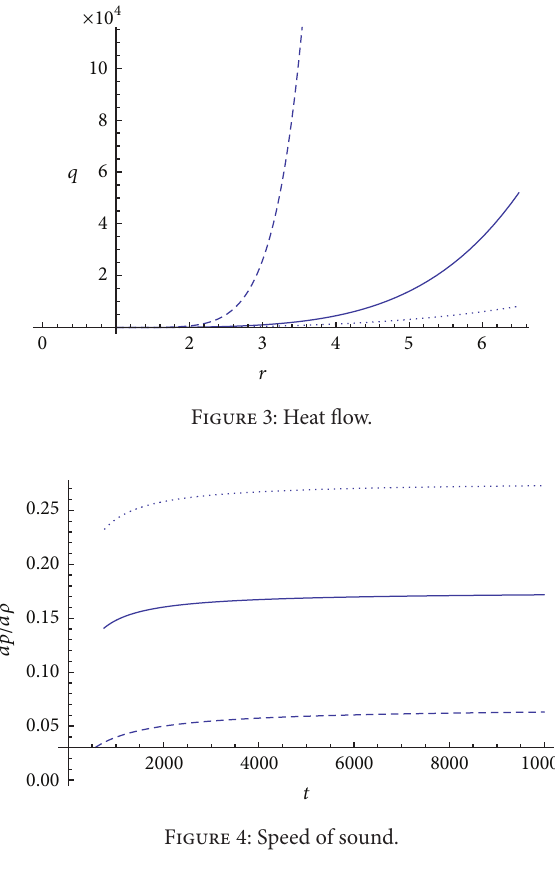
Figure 2: Pressure.